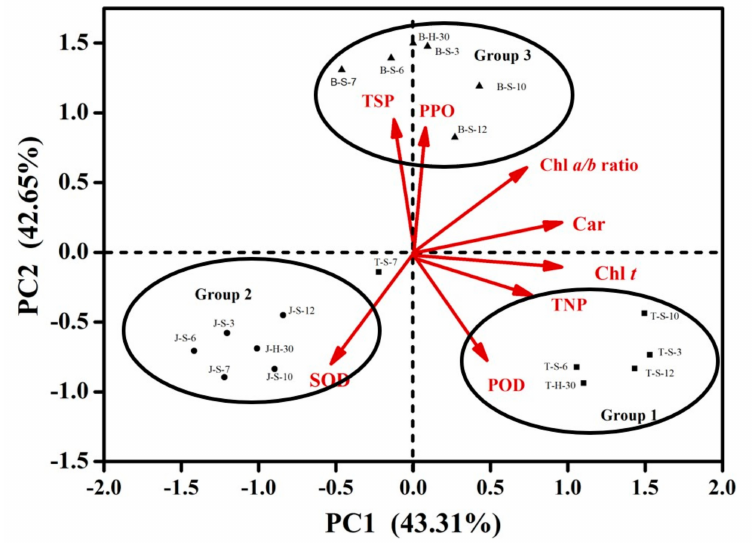
Figure 4. Principal component analysis (PCA) of the cultivar × development interactions in six barley cultivars at three developmental stages. PC1 accounted for 43.31% of variance and PC2 accounted for 42.65% of variance. T—tillering stage, J—joingting stage, B—booting